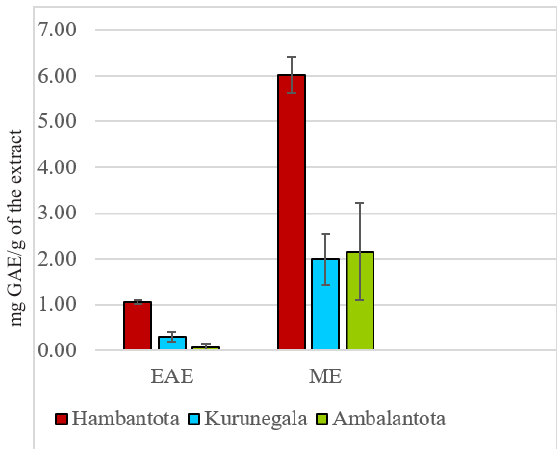
Figure 3: Comparison of total polyphenolic content.